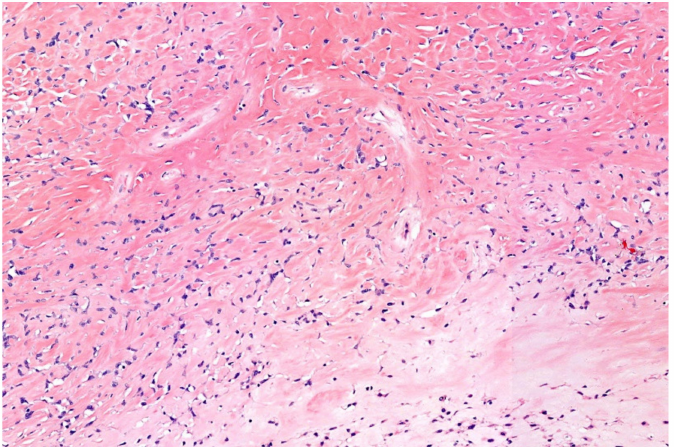
Figure 12. Sclerosing epitheloid fibrosarcoma, demonstrated by cords of bland looking epitheloid cells in a sclerotic stroma. Note pseudoangiomatous shrinkage artefacts (20 ×